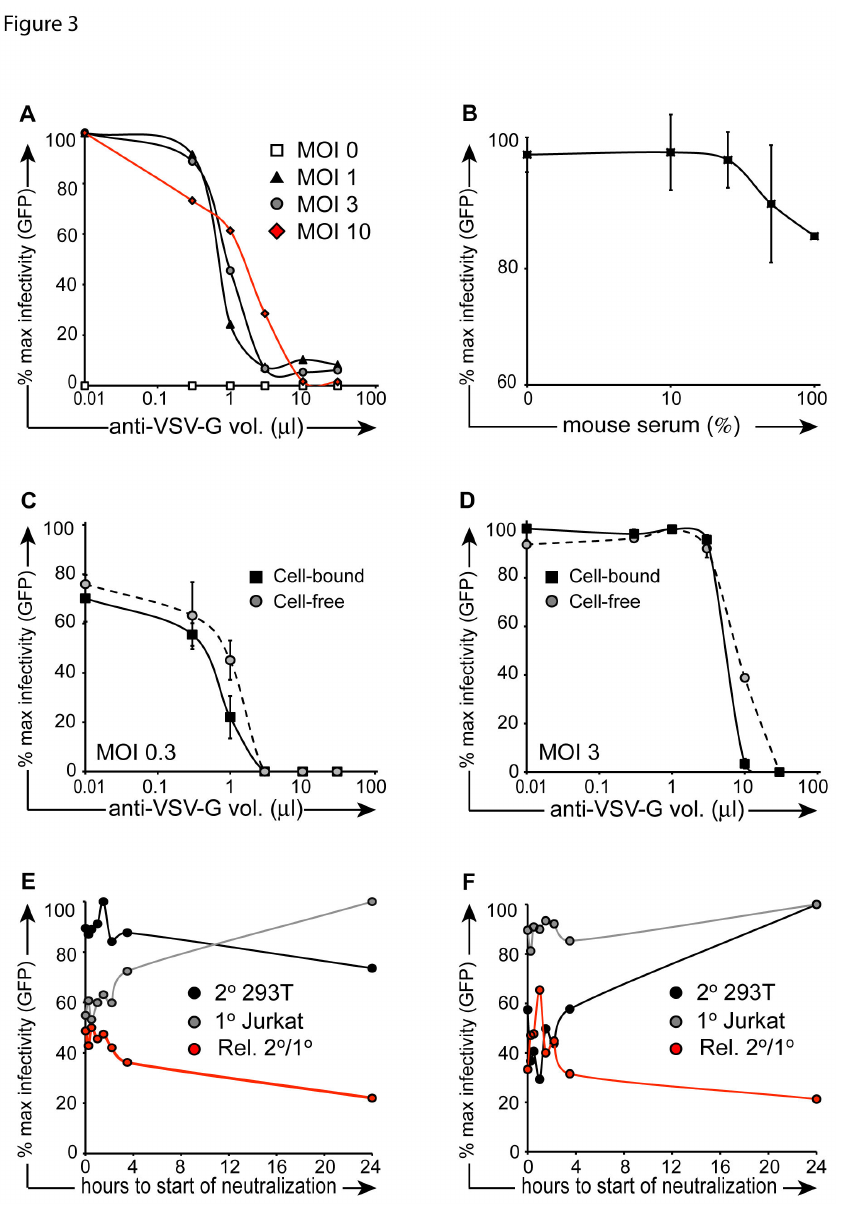
Figure 3. Neutralization kinetics of cell-free vector. ( A ) Vector particles were incubated in escalating concentrations of anti- VSV-G neutralizing antibody for 1 hour at 4°C in the presence of 4 µg/ml protamine sulfate. Particles were then placed on 293T cells for overnight transduction at 37°C. Cells were washed after 24 hours, and FACS was performed 48 hours later. ( B ) Experiment was performed as described in (A) with the exception that mouse serum was used instead of VSV-G neutralizing antibody and the neutralizing incubation was performed at 37 ° C for the purpose of minimizing cell death resulting from serum incubation (CD). In the cell-bound condition (black squares), 1x10 5 prechilled Jurkat cells were exposed to vector ( C : MOI 0.3; D : MOI 3) for 1 hour at 4°C in the presence of 4 µg/ml protamine sulfate, then placed in co-culture with 2.5x10 4 pre-plated 293T cells at 37 ° C. Cell-free samples (gray circles) were prepared in parallel, in the absence of Jurkat cells. Escalating concentrations of anti-VSV-G neutralizing antibody were added to co-cultures and incubataed overnight at 37°C. Cells were then washed, and FACS was performed 48 hours later (EF). 1x10 5 prechilled Jurkat cells were exposed to vector (MOI 3) for 1 hour at 4°C, then placed in co-culture with 2.5x10 4 pre- plated 293T cells at 37°C. At serial time points ( x -axis), 0.5% anti-VSV-G neutralizing antibody (E) or 10% mouse serum (F) was added to the transduction culture. Target 293T cells were washed 24 hours after vector exposure, and FACS was performed 48 hours later. CD45-APC antibody was used to exclude primary Jurkat cells (gray circles) from secondary target 293T cells (black circles). Red line depicts % 293T GFP+ events/ % Jurkat GFP+ events. doi: 10.1371/journal.pone.0074925.g003 PLOS ONE |